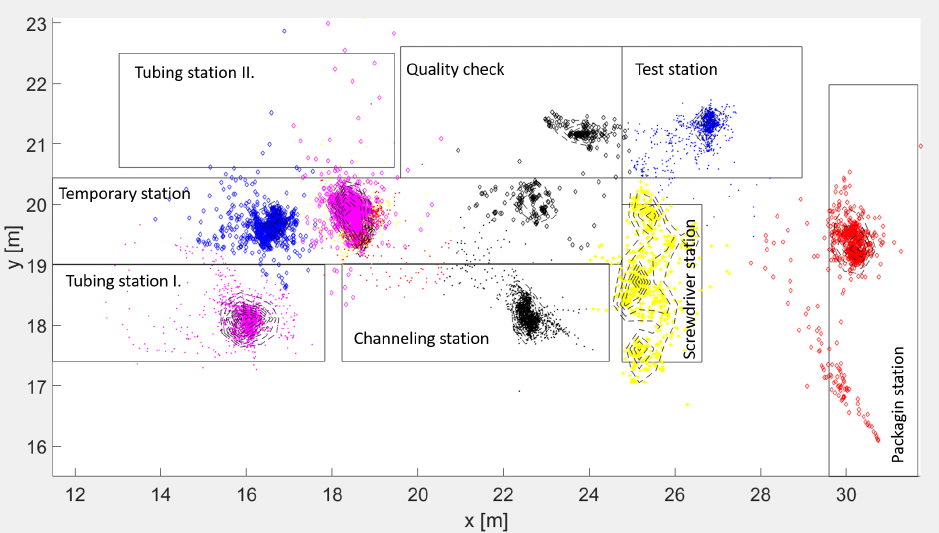
Figure 9. The production layout with seven pre-defined workstations. The classified and pre-defined (rectangles) zones are shown. The algorithm detects three small areas behind the Temporary station and indicates that Tubing station II was not used in this